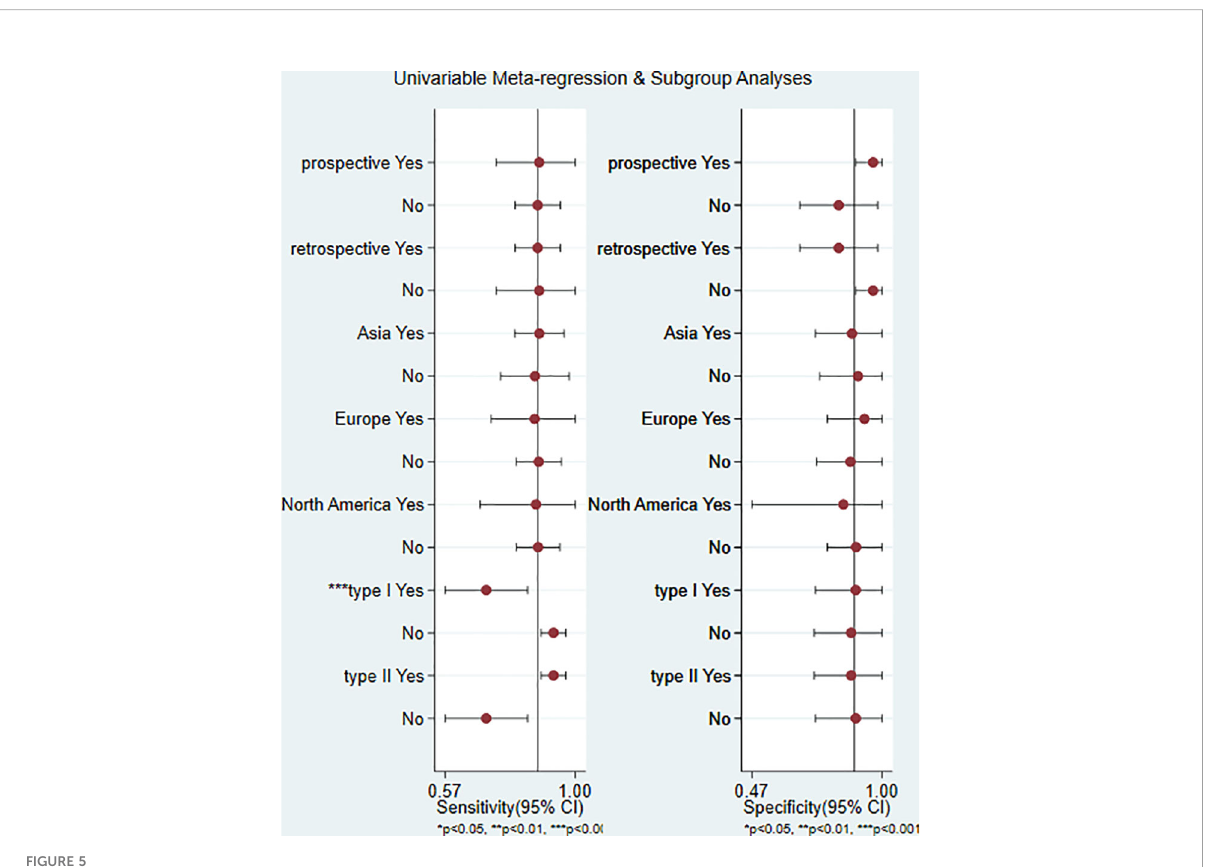
FIGURE 5 Meta-regression and subgroup analyses.